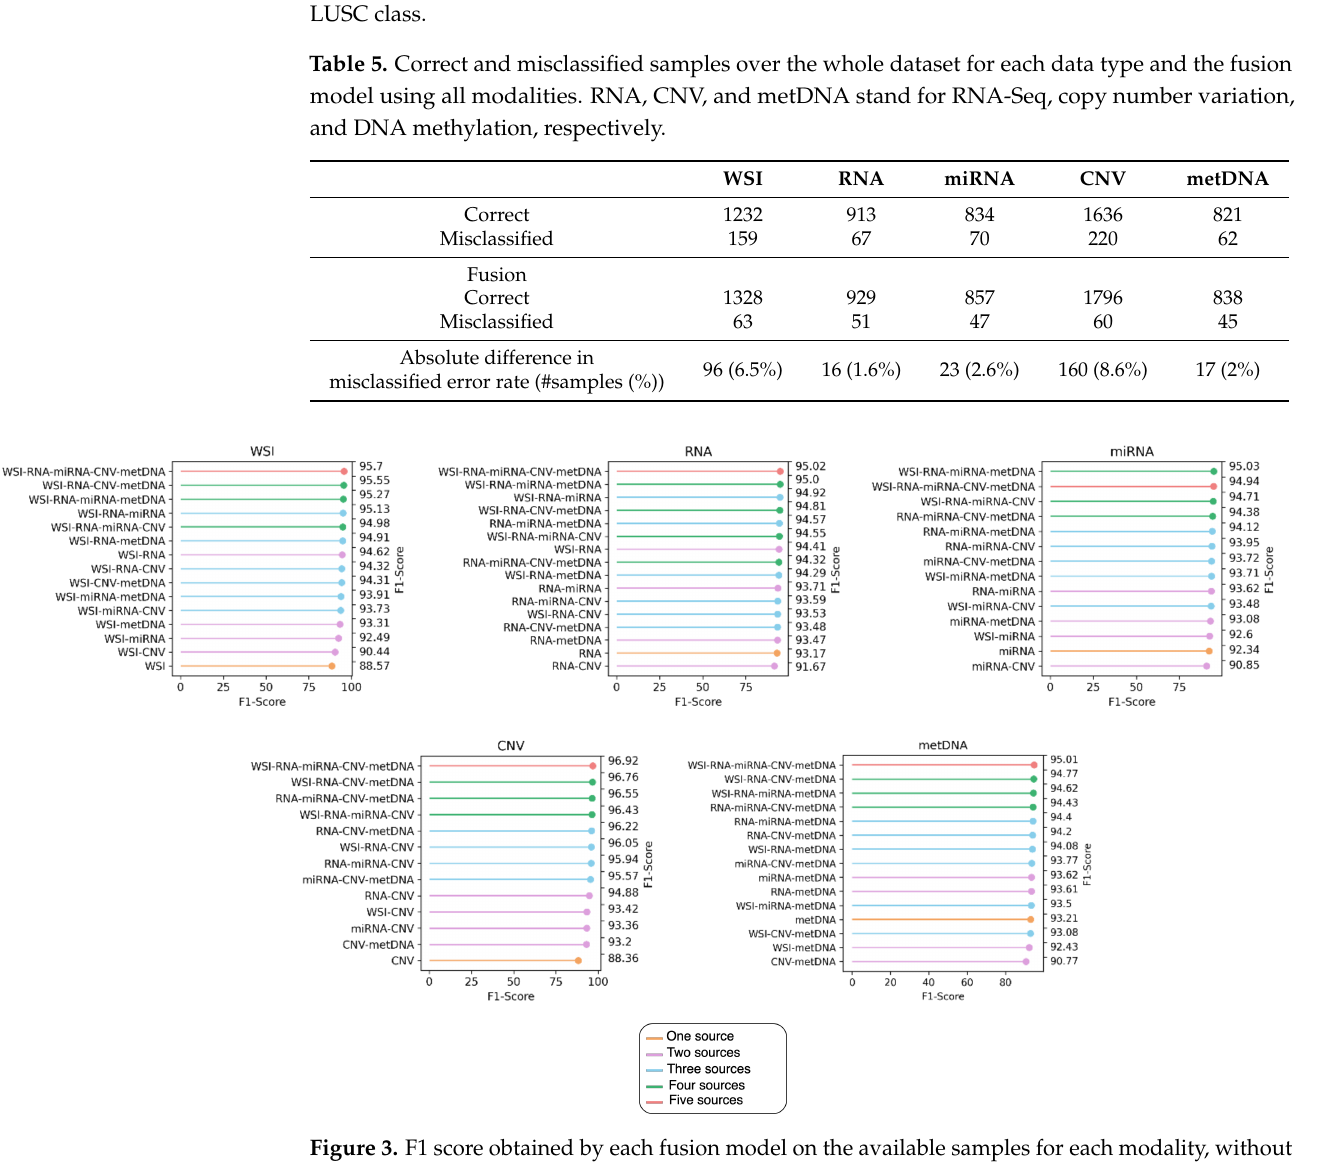
Figure 3. F1 score obtained by each fusion model on the available samples for each modality, without restricting to those in common between the different modalities (see Table 2 to check the number of samples per class). On the left Y-axis the sources used in the integration are shown, while on the right Y-axis the F1 score obtained by each integration can be observed. They are ordered from the highest F1 score to the lowest. metDNA stands for DNA methylation and CNV for copy number